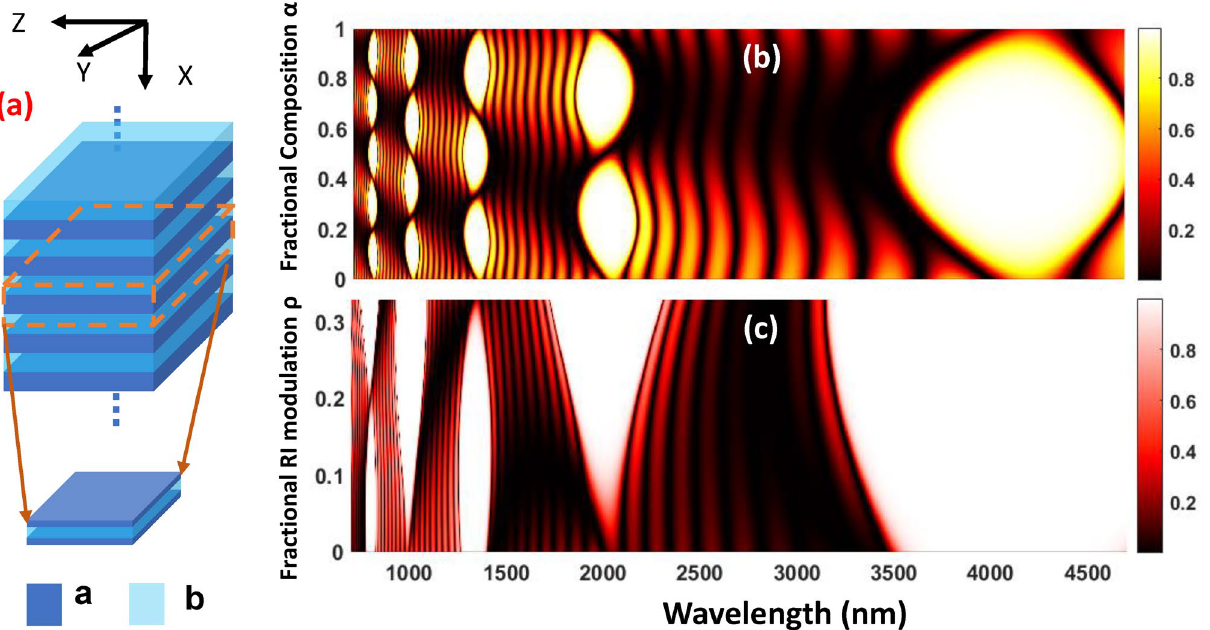
Figure 1. ( a ) Schematic for a 1D PhC with inversion sysmmetric unit cells (dashed line in schematic); ( b ) parametric behaviour of PhC reflectance with the unit-cell composition fraction α ; (c) parametric behaviour of PhC reflectance with the fractional RI modulation parameter ρ